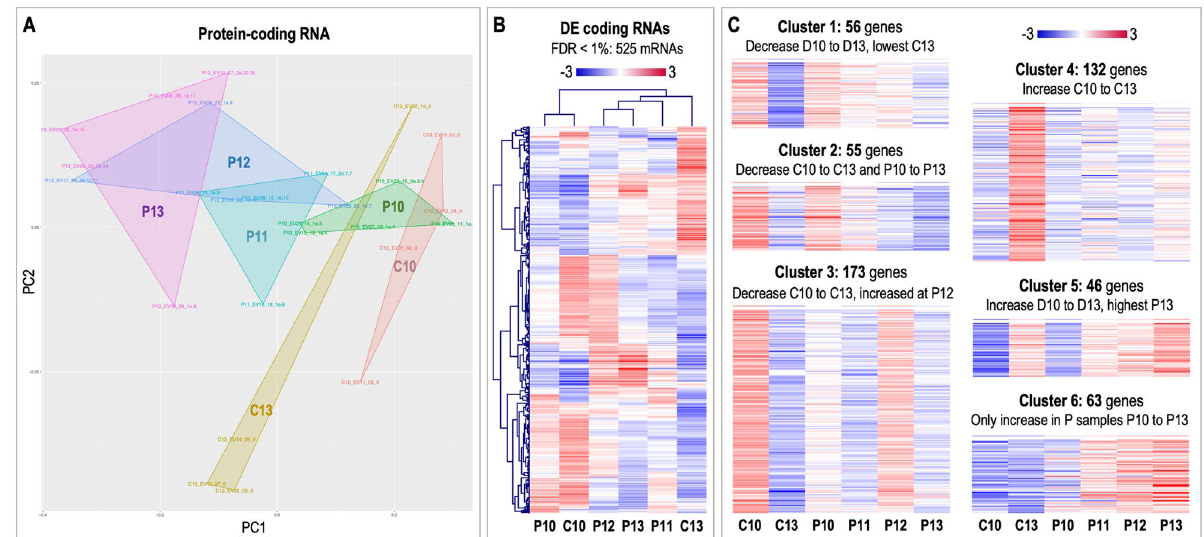
Figure 4. Differential analysis of protein-coding RNAs in uterine EVs across samples. ( A ) Principal component analysis (PCA) based on protein-coding RNA (mRNA) for all experimental groups (pregnancy days 10, 11, 12, and 13: P10, P11, P12, and P13; cyclic controls days 10 and 13 post-ovulation: C10, C13). ( B ) Mean- centered log2 counts per million (cpm) values were calculated (log2 of CPM of respective sample – mean of all samples) for mRNAs DA across samples (FDR 1%). Hierarchical cluster analysis (HCL) (Pearson correlation, MeV software) was performed across experimental groups for differentially abundant (DA) mRNAs. ( C ) Self-organizing tree algorithm (SOTA) analysis was used to identify clusters of genes with similar expression profiles across experimental groups. Six clusters of protein-coding RNA across samples were obtained, with six expression images showing the number of genes and expression profiles in each SOTA cluster. PCA image was created with Bioconductor package EdgeR (https:// bioco nduct or. org/ packa ges/ relea se/ bioc/ html/ edgeR. html) 91 and other standard R packages. HCL and SOTA expression images were created with Multiple Experiment Viewer (MeV v.4.8.1, https:// sourc eforge. net/ proje cts/ mev- tm4/) 93 . Images were modified in Adobe Photoshop v.22.4.3. Labelling of each sample refers to: day of pregnancy or cycle; followed by the number of EV sample from 1 to 24; followed by the number of endometrial sample collected at the same time and analyzed in a parallel study 56 ; followed by the embryo size (e.g., 1e.5: one embryo collected with 5 mm diameter; 2e.3.4 = two embryos were collected with 3 and 4 mm; nd: the diameter could not be determined, embryo broken during collection; 0: for control Metascape enrichment analysis provided GO terms similar to DAVID for each individual SOTA cluster (data not shown). Moreover, Metascape showed that the 6 SOTA clusters were each enriched for specific GO terms with little overlap in biological functions and pathways as shown in Fig. S5. Results for all DA mRNAs are provided in Supplementary data S2. In addition, the Metascape Membership function was used to search for significant enrichment ( P < 0.05) of terms matching the keywords “embryo”, “endometrium, “uterus”, “immune system”, “estradiol”, “estrogen”, “progesterone”, and “prostaglandin”. Figure 5 illustrates the results of this analysis. The term “embryo” was significant for the genes in cluster 4 (20 genes, 1.7-fold enrichment). For “uterus”, clusters 4 and 6 showed overrepresentation (7 and 5 genes, 4.2-fold and 6.2-fold enrichment, respectively). Cluster 4 was also found as enriched for “endometrium” (6 genes, 10.7-fold enrichment, respectively). The keyword “immune system” showed significant overrepresentation for clusters 3, 4, and 6 (51, 23, and 18 genes, 2.5-fold, 1.5-fold, and 2.3-fold enrichment, respectively). In contrast, “estradiol” and “estrogen” were overrepresented for clusters 2 and 4 (estradiol: 4 and 5 genes, 8.5-fold and 4.6-fold enrichment, respectively; estrogen: 6 and 7 genes, 5.2-fold